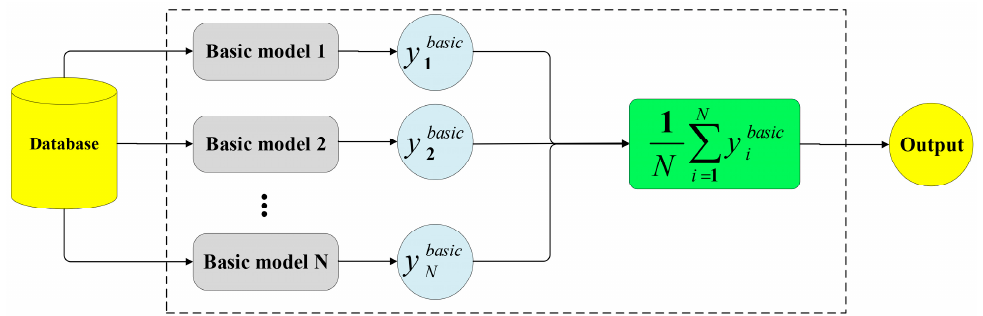
Figure 2. Workflow of SAE procedure.